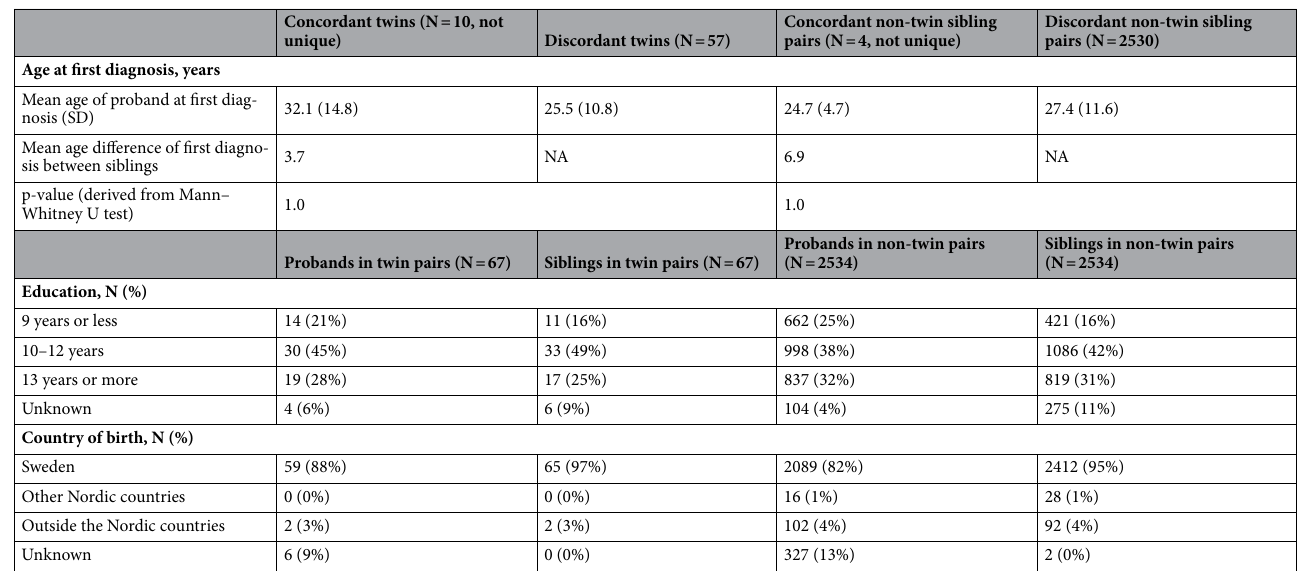
Table 1. Characteristics of the study